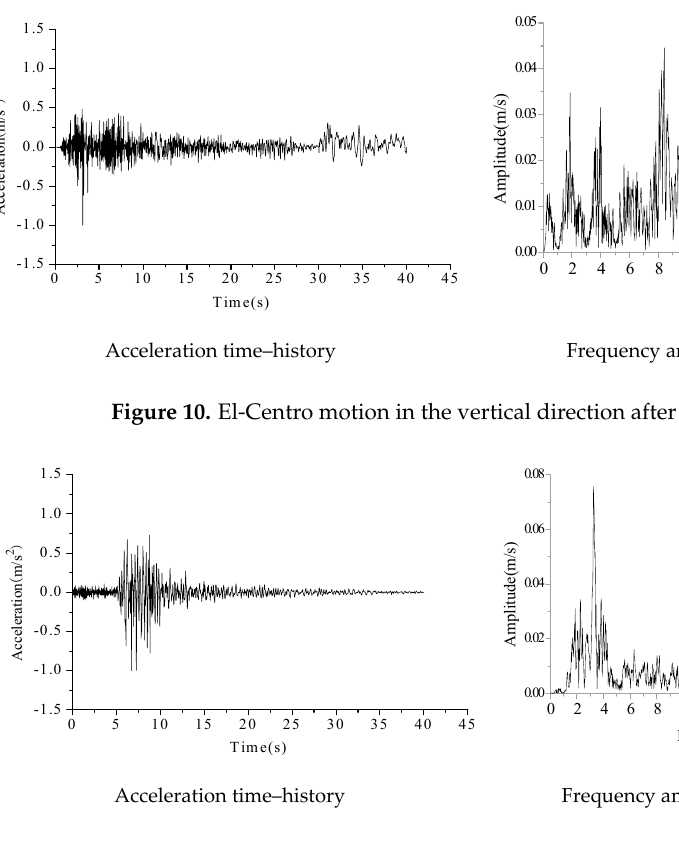
Figure 9. El-Centro motion in the horizontal direction after inversion.